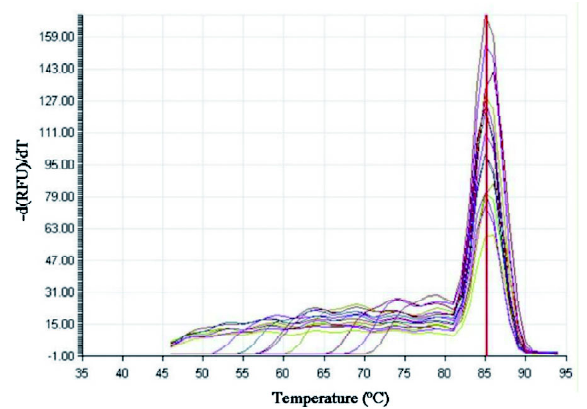
Fig. 1 - The melting curves indicated a single peak with a melting temperature (Tm) of 85.1ºC for the